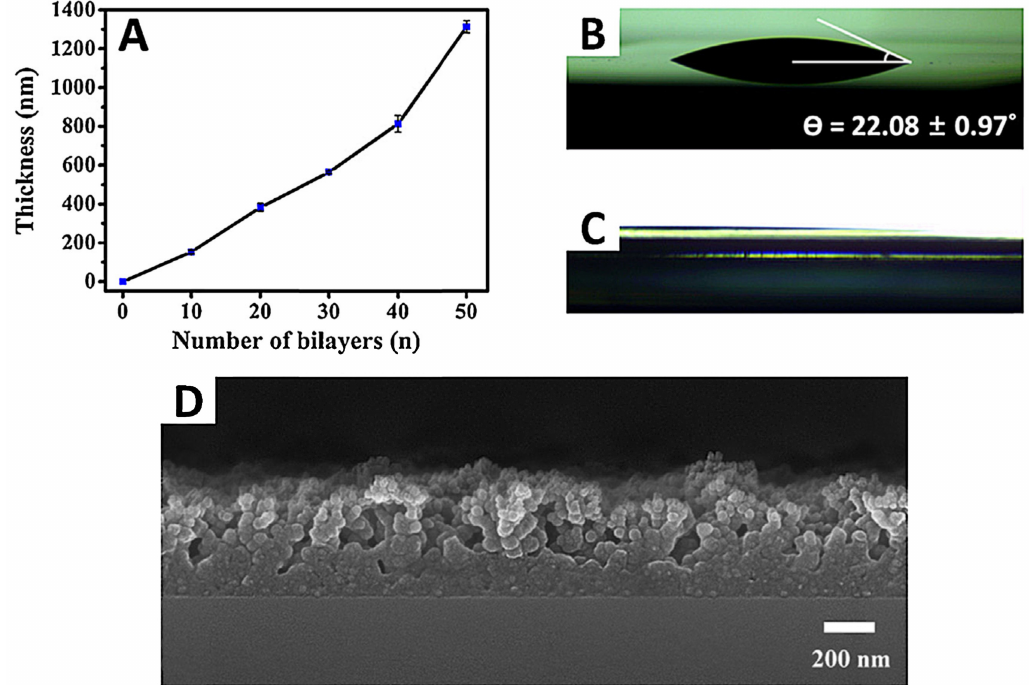
Figure 6. Characteristics of (BPEI/SiSQ) n films. ( A ) Thickness growth curve of (BPEI/SiSQ) n film (number of layers, n = 0, 10, 20, 30, 40, and 50). Static contact angle of ( B ) the bare silicon wafer as a control, ( C ) the (BPEI/SiSQ) 20 film. ( D ) FE-SEM cross-sectional image of (BPEI/SiSQ) 20 film. Reprinted with permission from Lin, X.; Hwangbo, S.; Jeong, H.; Cho, Y.A.; Ahn, H.W.; Hong, J. J. Ind. Eng. Chem. 2016 , 36 , 30–34